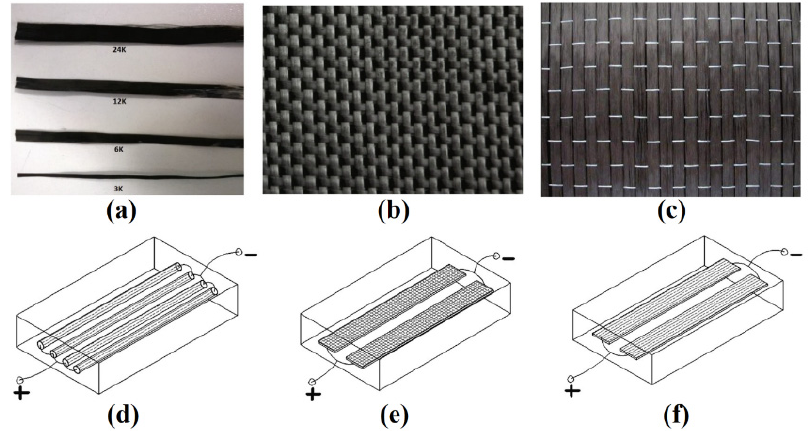
Figure 17. ( a – c ) Forms of carbon fibers; ( d – f ) schemes of heating panels based on carbon fibers embedded in concrete blocks. Reprinted with permission from [91].